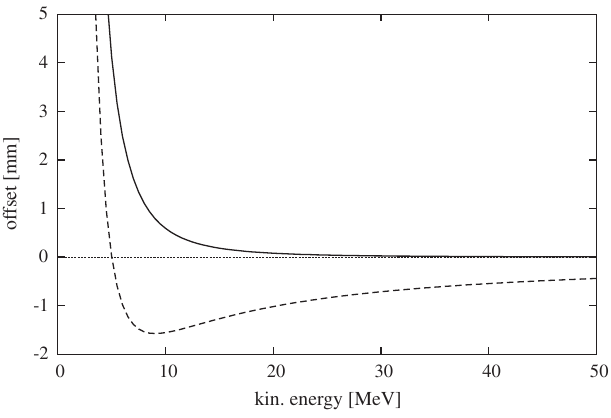
¼ 1 , the broken m